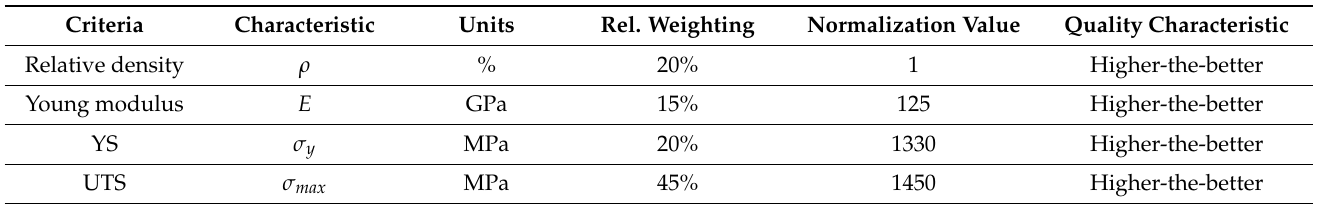
Table 6. Evaluation criteria, relative weights, and normalization values. All characteristics are of the higher-the-better type.